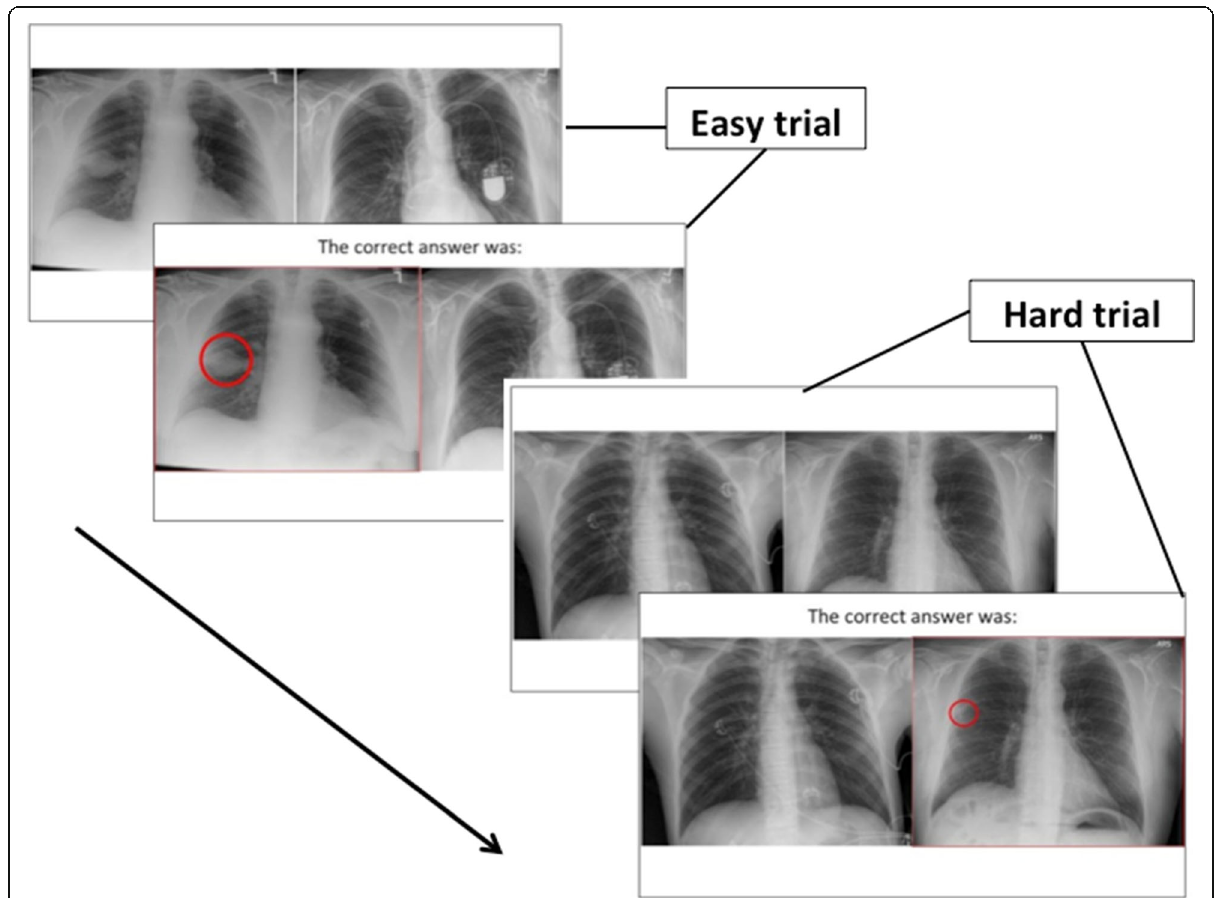
Fig. 1 Example trials from the Vanderbilt Chest Radiograph Test (VCRT). Subjects responded by clicking on the nodule and were then given feedback and shown the nodule for 2000 ms. The upper trial is an example of an easy trial and bottom trial is an example of a more difficult